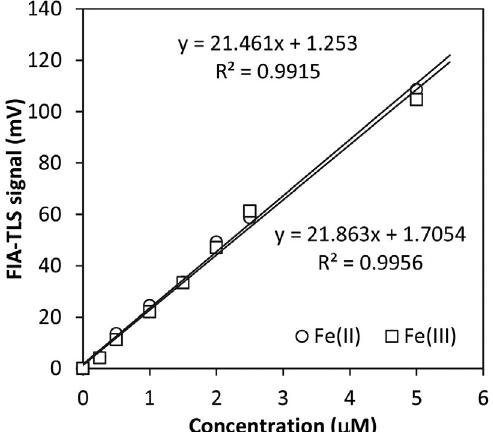
Figure 8. Calibration curve for determination of Fe(II) and Fe(III) by FIA-TLS with 1 mM PHN as carrier solution